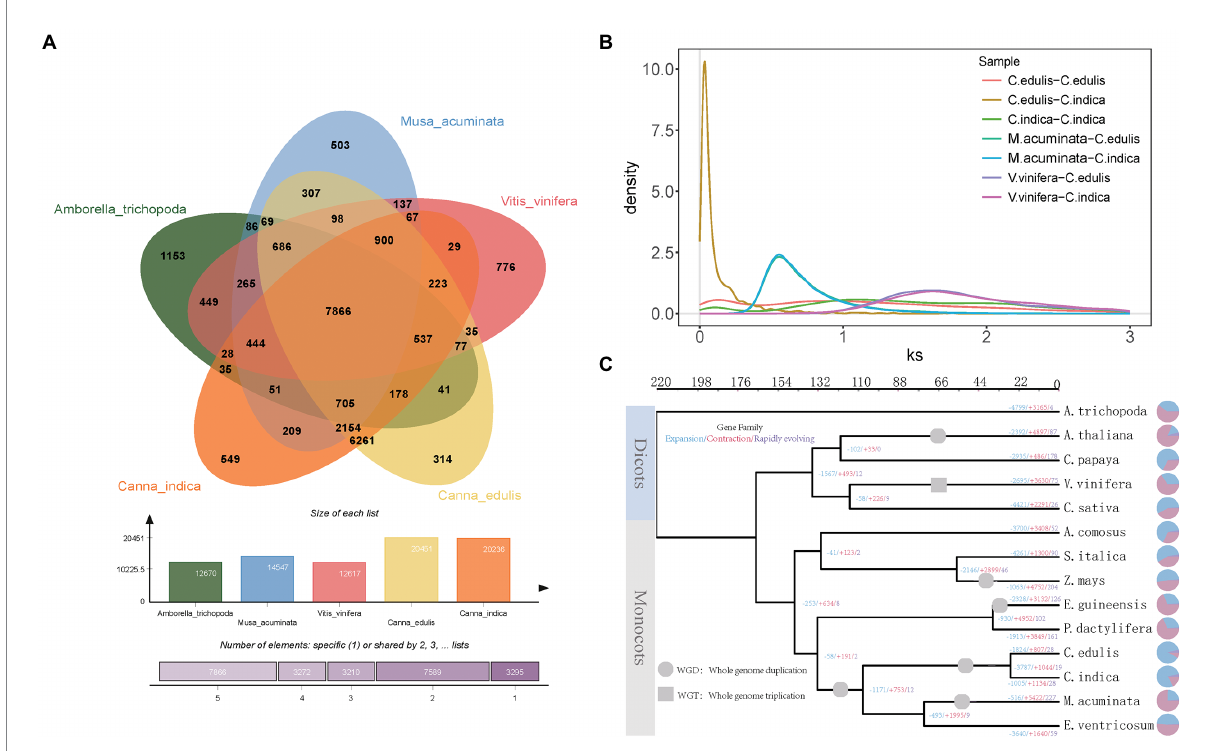
FIGURE 2 (A) Analysis of gene families of five species ( Canna edulis , Canna indica , Amborella trichopoda , Musa acuminata , and V. vinifera ). (B) Frequency distribution of synonymous substitution rates (Ks) between homologous gene pairs in syntenic blocks of C. edulis - C. edulis , C. indica - C. indica , C. edulis - C. indica , M. acuminata - C. edulis , M. acuminata-C. indica , V. vinifera - C. edulis , and V. vinifera - C. indica . (C) Phylogenetic tree of 14 species constructed using single-copy orthologous